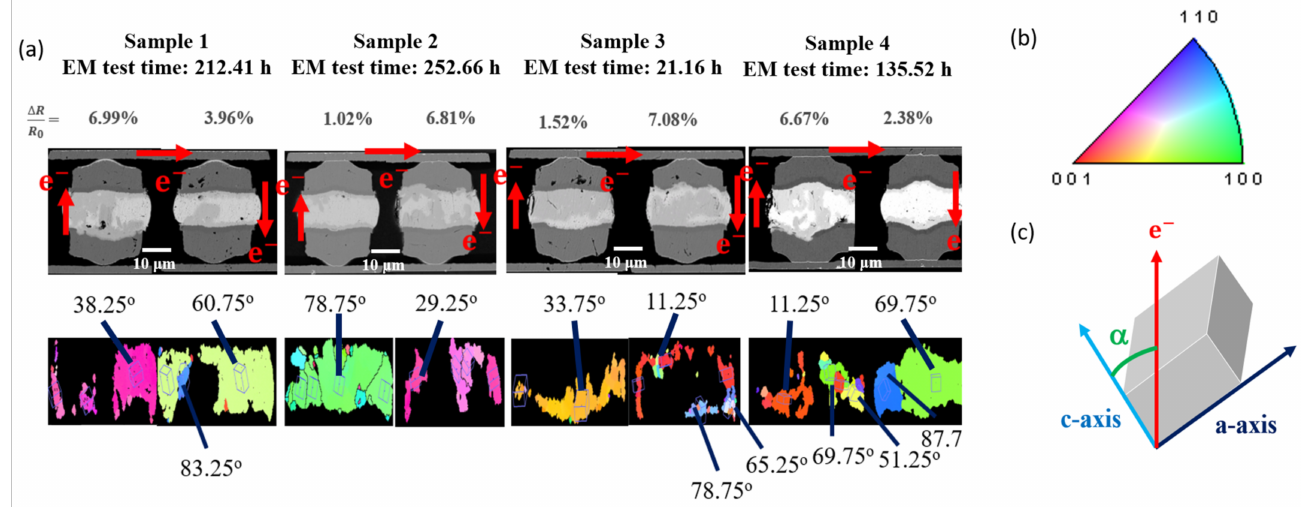
Figure 7. ( a ) Cross-sectional FIB and EBSD images of the solder joints with different α -angle stressed at a low current density. ( b ) Inverse pole figure of the β -Sn. ( c ) Schematic diagram showing the definition of α -angle. The electrical flows are denoted by the red